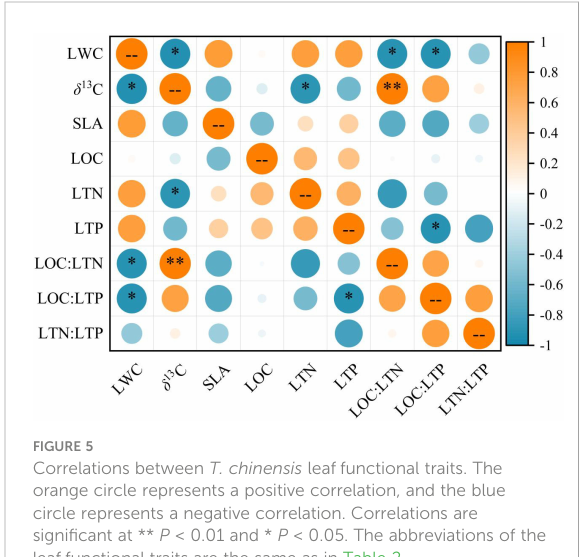
FIGURE 5 Correlations between T. chinensis leaf functional traits. The orange circle represents a positive correlation, and the blue circle represents a negative correlation. Correlations are signi fi cant at ** P < 0.01 and * P < 0.05. The abbreviations of the leaf functional traits are the same as in Table 2.